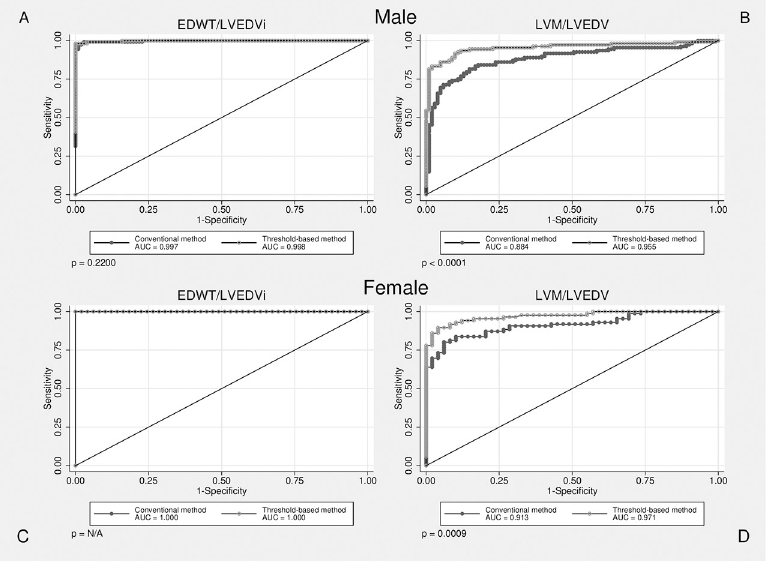
Fig 4. ROC curves visualizing correct identification of HCM among male and female subjects, p values represent the difference in diagnostic performance between conventional and threshold-based quantification methods.